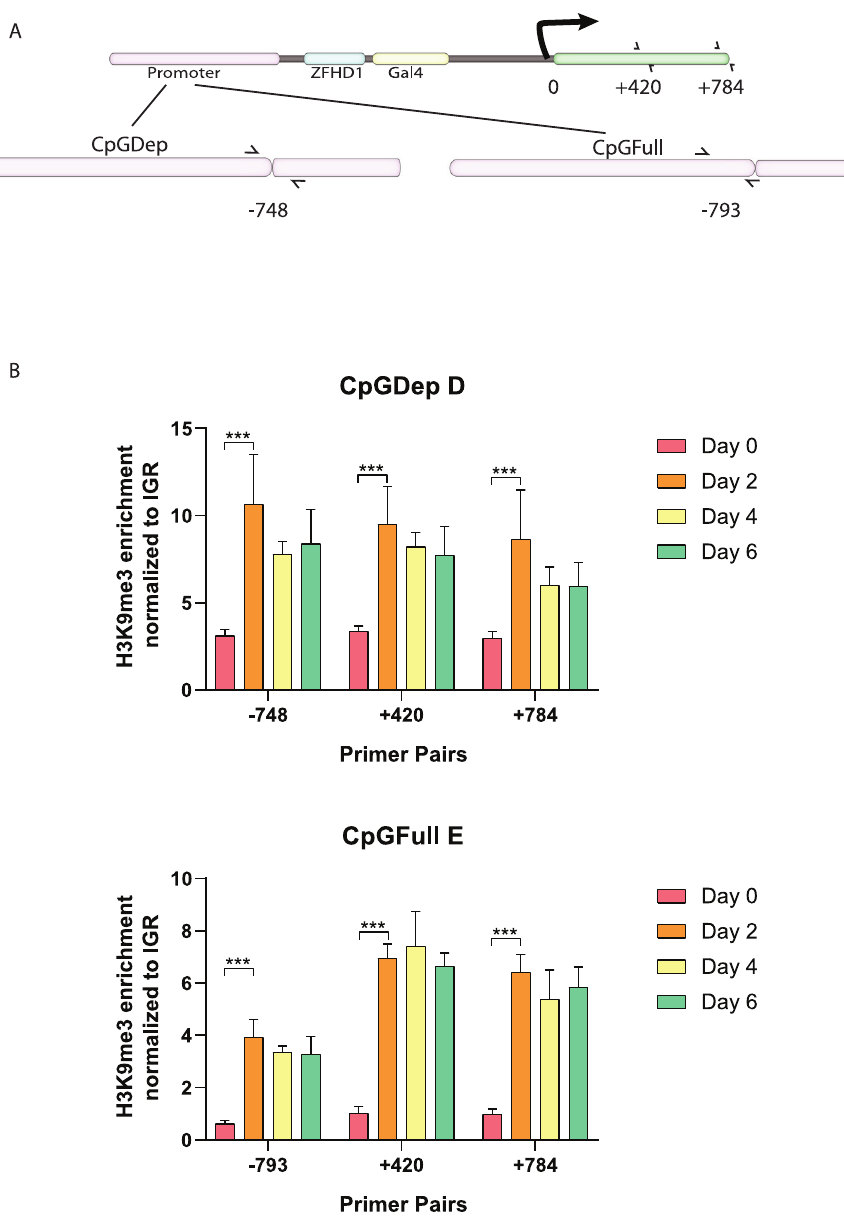
Fig 3. Enrichment of H3K9me3 in two cell lines during six days of CIP. A) Position of qPCR primers along gene body and promoters in CiA cell lines. Primers are depicted as black arrows, and primer sequences can be found in Table 1. B) Relative H3K9me3 enrichment for each primer set at days 0, 2, 4 and 6 post CIP. Each sample contains two biological and three technical replicates, n = 6. �� P � 0.01. ��� P � 0.001. Significant difference between Day 0 and Day 4, and between Day 0 and Day 6, was also found in both cell lines, with all four primer sets. P �